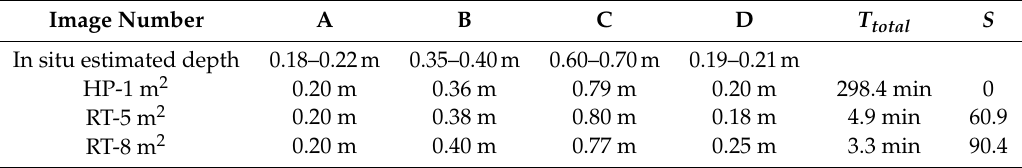
Figure 13. In situ observations captured during the May event in the center of Aachen; locations are indicated by ( A – D ) shown on the map Figure 11; flood depths estimations are marked with a red square. Table 3. Estimated observed depths and simulated depths for selected locations in the central areas of Aachen including total computation times ( T Total ) and speedup ratio ( S ) for different simulations.